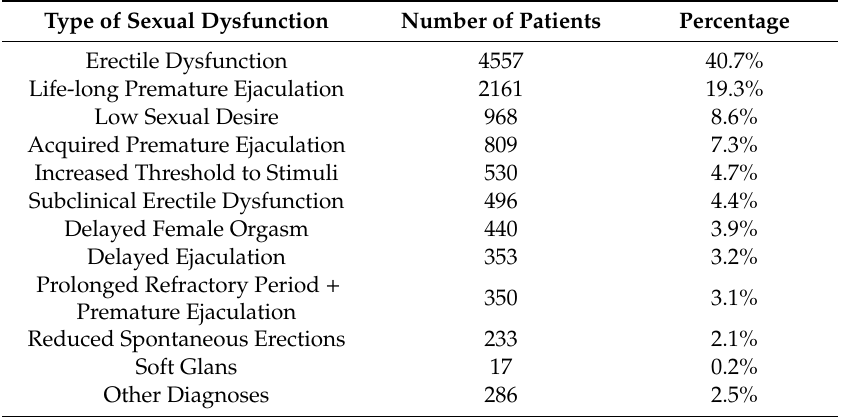
Table 2. Prevalence of final diagnoses at the end of a complete clinical